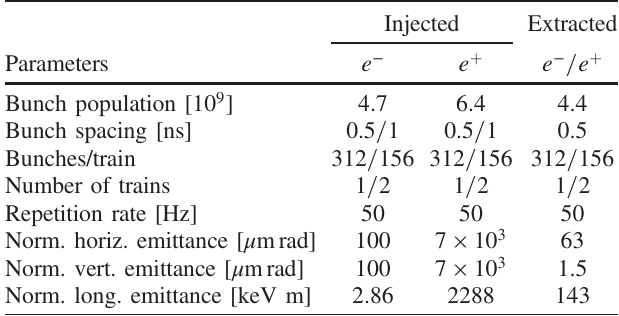
TABLE I. Parameters before the injection to the predamping rings and before the injection to the main damping